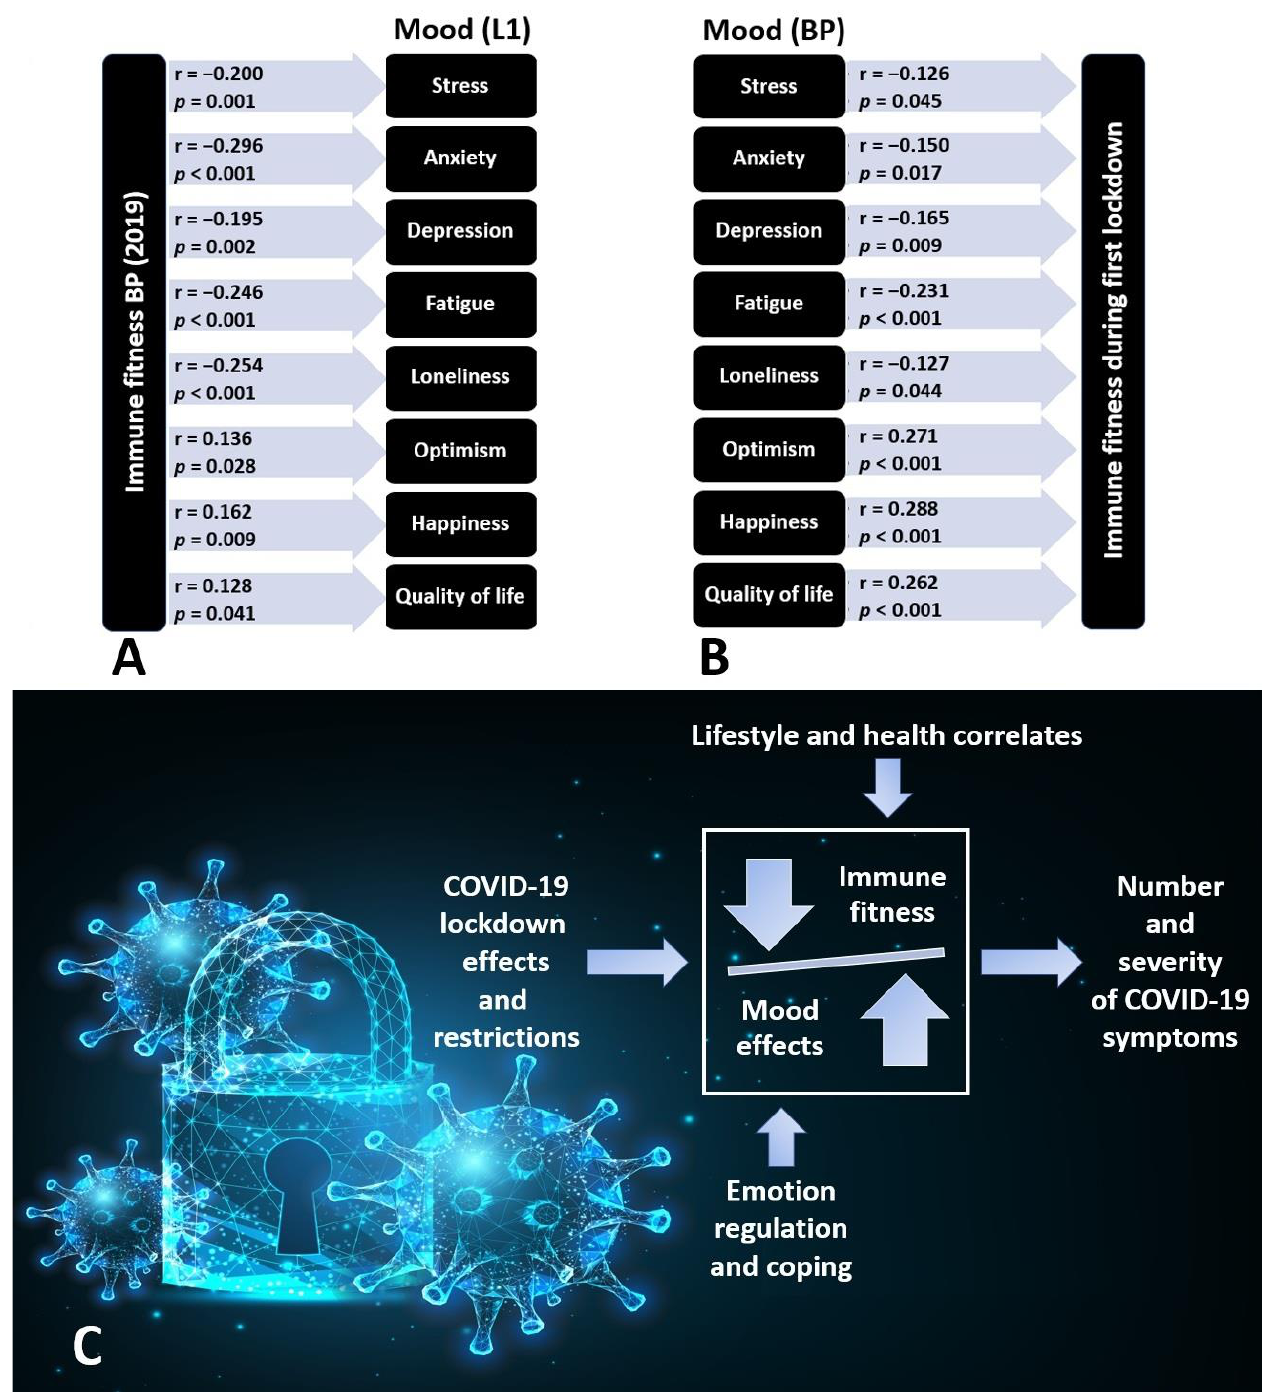
Figure 2. The bi-directional relationship between mood and immune fitness. Spearman’s correlations and p -values are shown. ( A ) Shows the correlations between immune fitness before the COVID-19 pandemic (assessed for 2019 with the ISQ [17]) and mood during the first lockdown period. ( B ) Shows the correlations between mood before the COVID-19 pandemic and immune fitness during the first lockdown period. ( C ) Summarizes the model that describes the impact of COVID-19 lockdown effects and its restrictions on mood and immune fitness, and the number and severity of COVID-19 symptoms. Abbreviations: BP = before the COVID-19 pandemic; L1 = the first